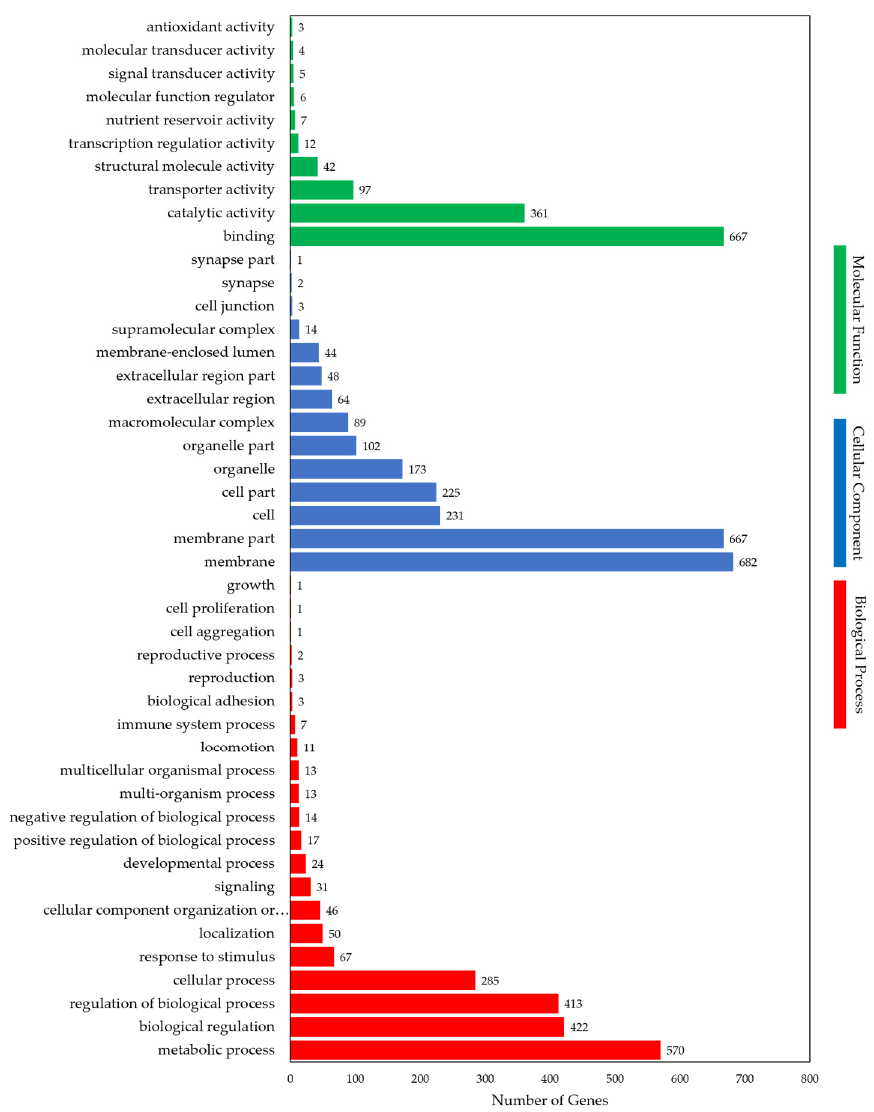
Figure 4. Gene Ontology classification of differentially expressed genes in wild-type and chlorophyll b -deficient rice.